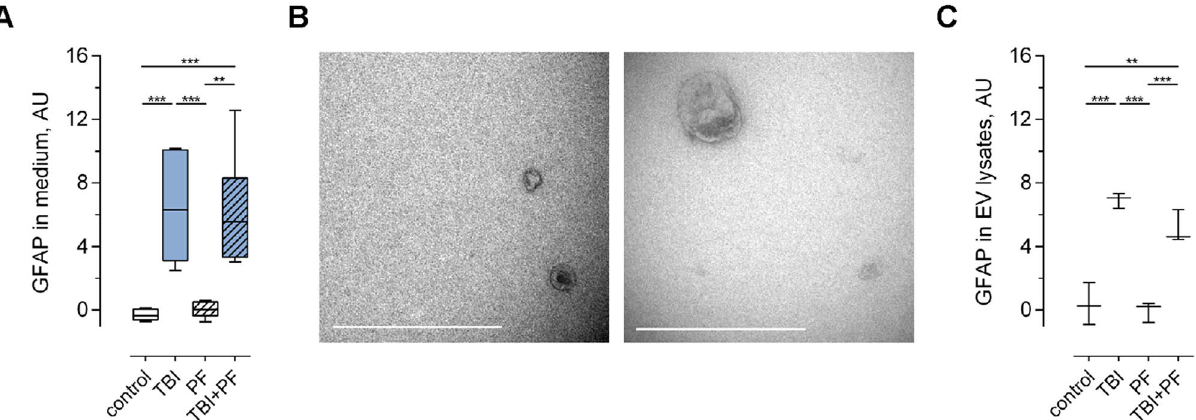
Figure 4. Increased levels of the astrocytic marker GFAP in the cell culture medium and in extracellular vesicles following TBI. ( A ) The level of GFAP in the cell culture medium was assessed by ELISA and was found to be increased following TBI exposure, but not in the control or PF experimental groups (independent cell cultures, n = 6). ( B ) Cell culture medium was ultracentrifuged and the successful isolation of EVs of various sizes was verified by TEM. ( C ) Following isolation, EVs were lysed and GFAP levels were analysed using ELISA (independent cell cultures, n = 3). Quantification established increased levels in the TBI and TBI + PF 500 nm ( B